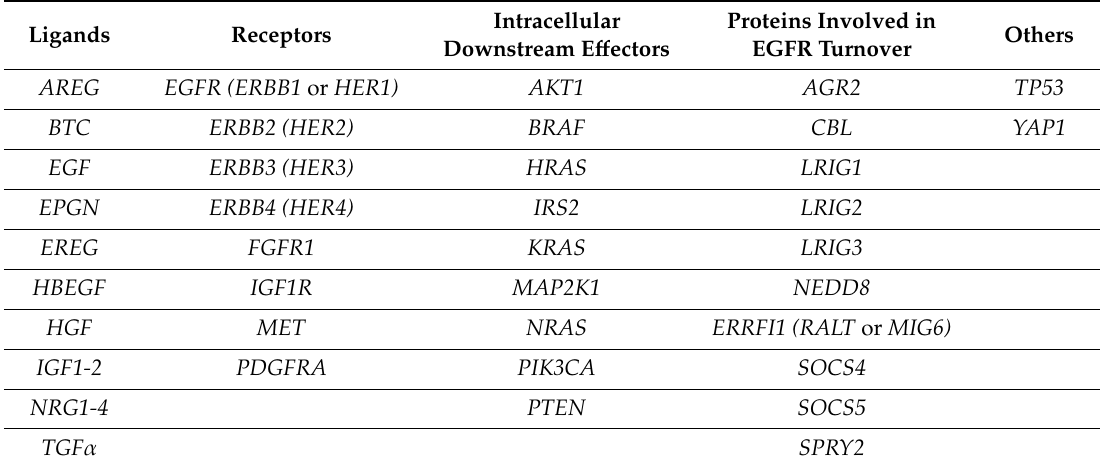
Table 1. Selected genes classified according to the function of their encoding